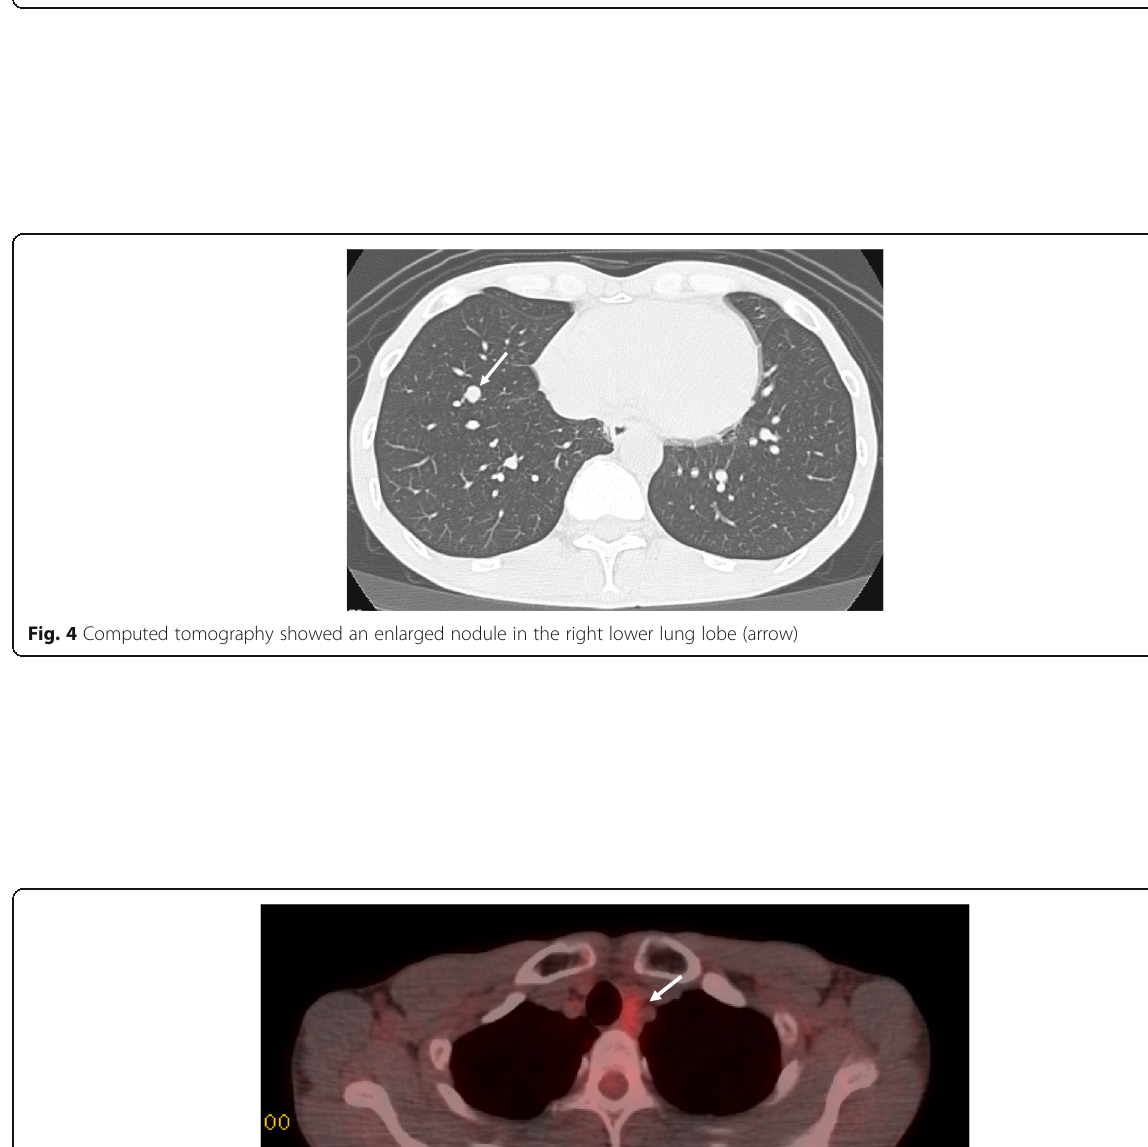
Fig. 3 Histopathological findings of the primary tumor. Original magnification × 40 ( a ). Original magnification × 400 ( b )